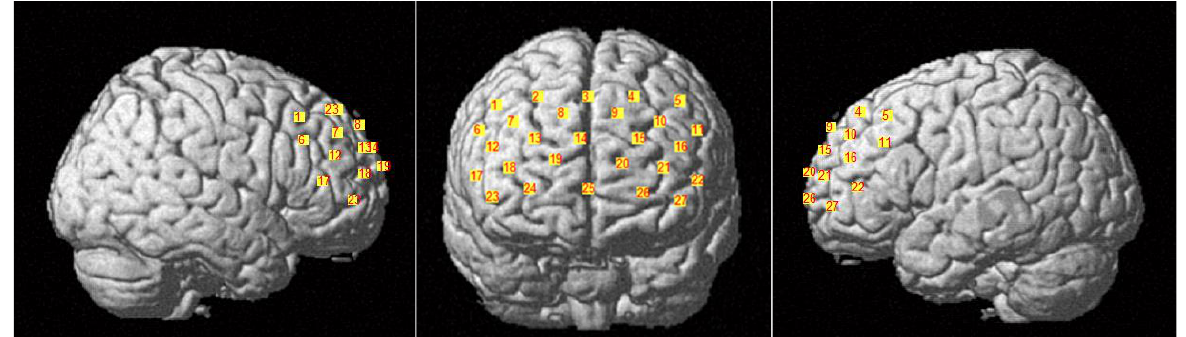
Figure 2. Positions of fNIRS probe set. The number on the yellow square background represents the position of the 27